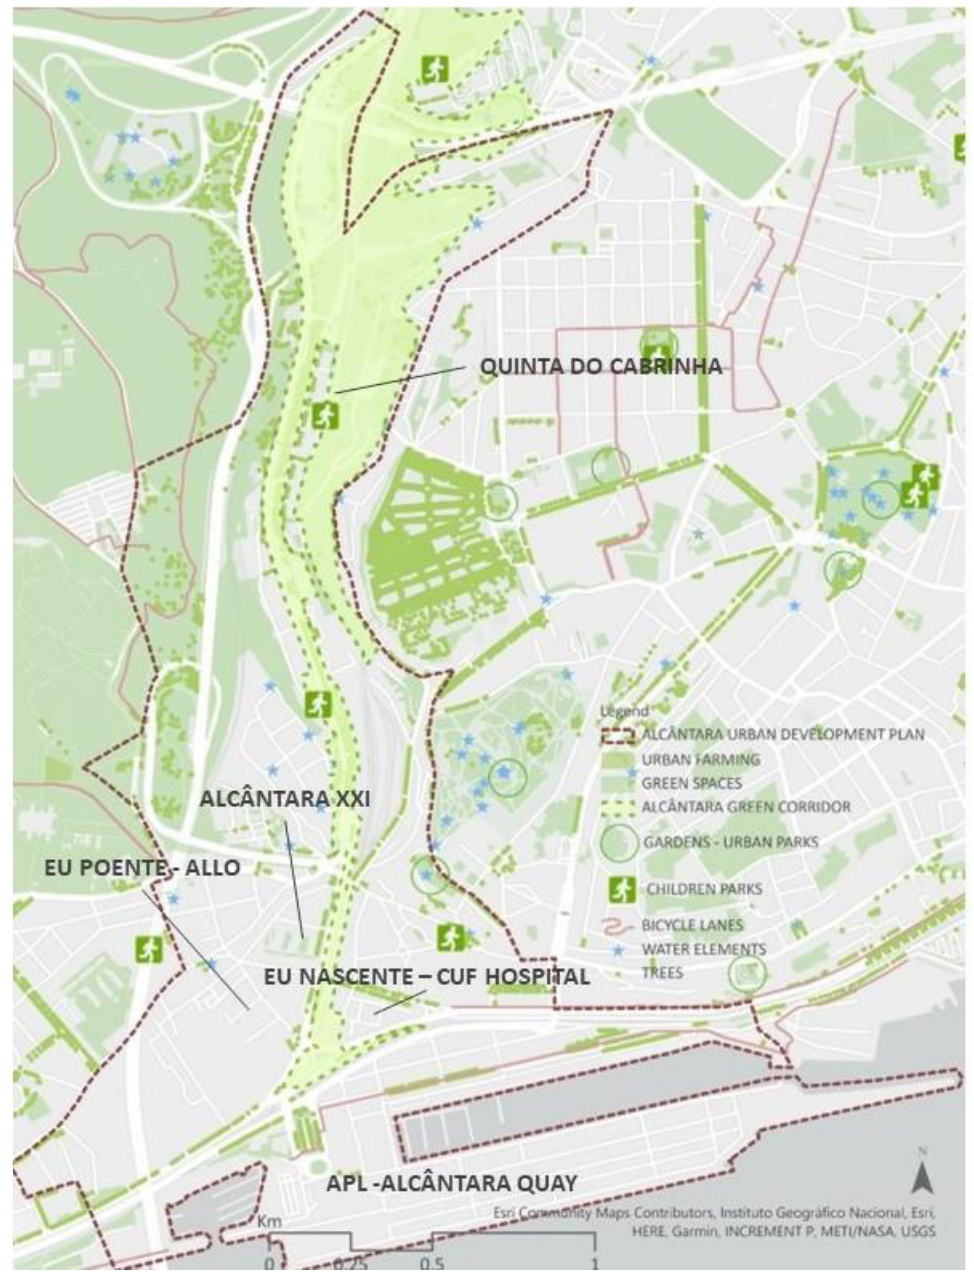
Figure 4. Urban Green Spaces, Alcântara Green Corridor, and the active Urban Development Plan (red) for Alcântara. Source: Own production adapted from CML open-source databases (see Backmatter, 07/11/2021).